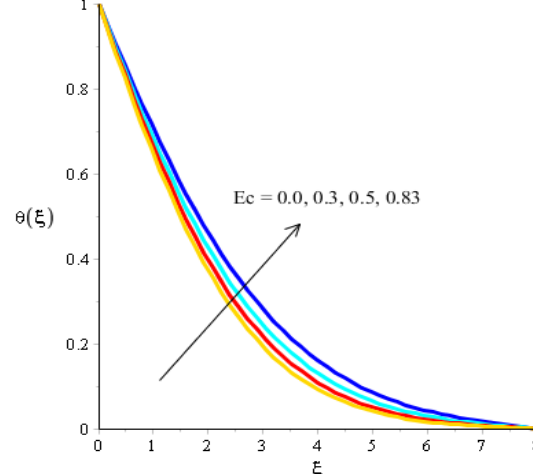
Figure 8. Analysis of the temperature curves versus 𝐸𝑐.